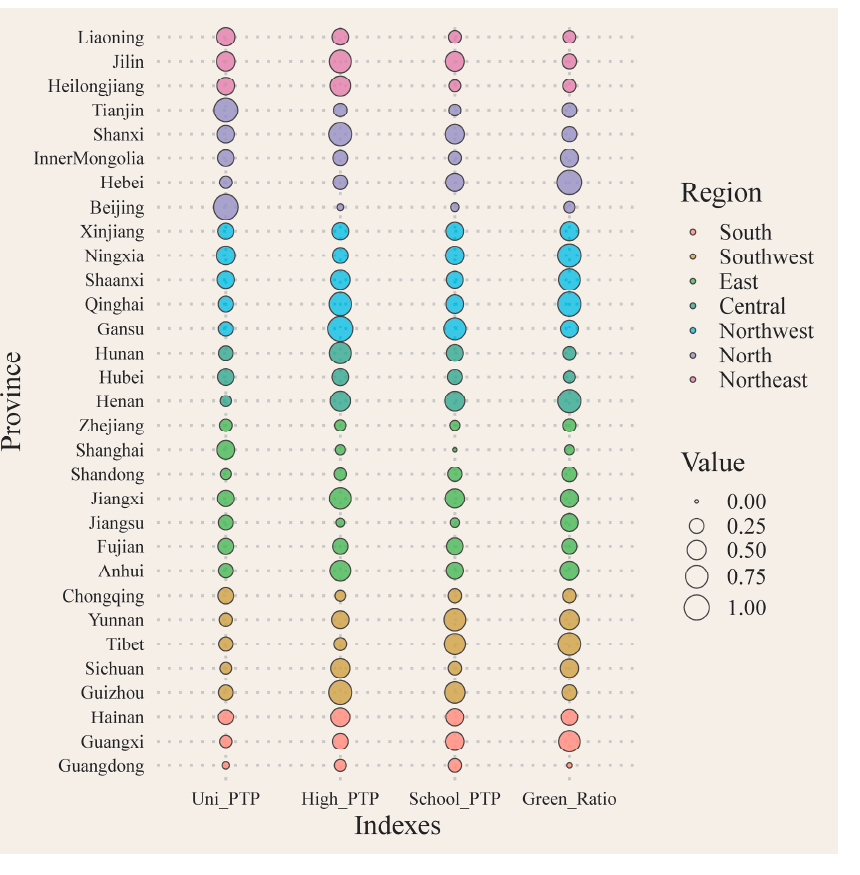
Figure 8. Distribution map of standardized values of main adaptability indicators for each province.